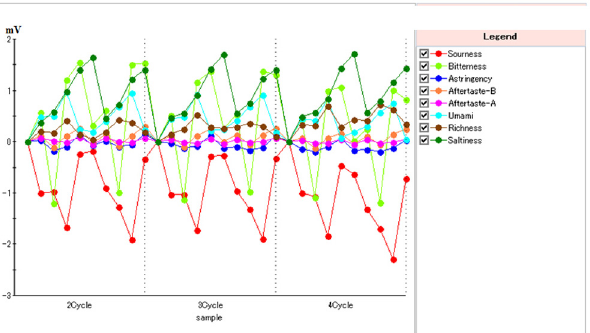
Fig 1. The stability of sensors response to various taste materials in the last three cycles of meat extract sample. Richness is Aftertaste from